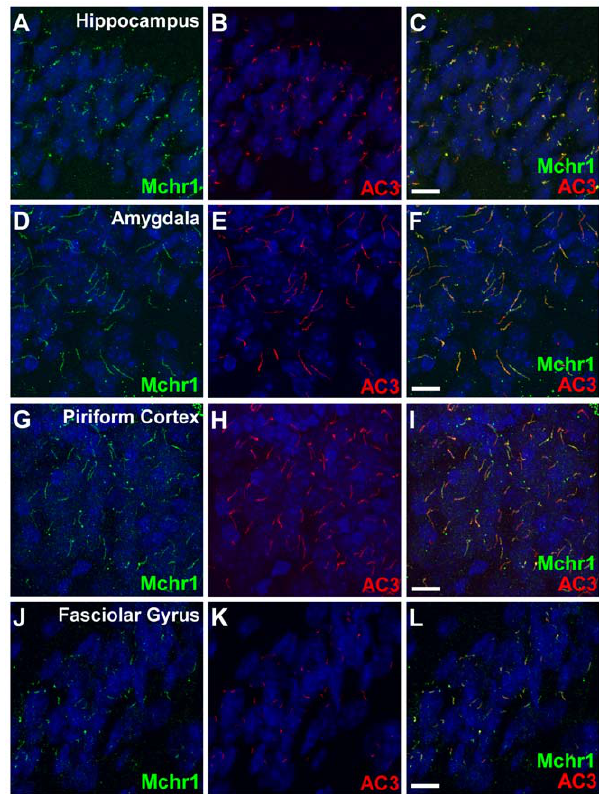
Figure 1. Mchr1 localizes to neuronal cilia throughout the mouse brain. (A–L) Representative images of multiple brain regions in 5–6 week old WT mice showing colabeling for Mchr1 (green) and AC3 (red). Nuclei are stained with DRAQ5 (blue). Labeling for AC3 reveals numerous primary cilia present throughout the CA1 region of the hippocampus (B), amygdala (E), piriform cortex (H), and fasciolar gyrus (K). Labeling for Mchr1 (A, D, G, & J) reveals abundant Mchr1 ciliary localization in each region. Merged images (C, F, I, L)